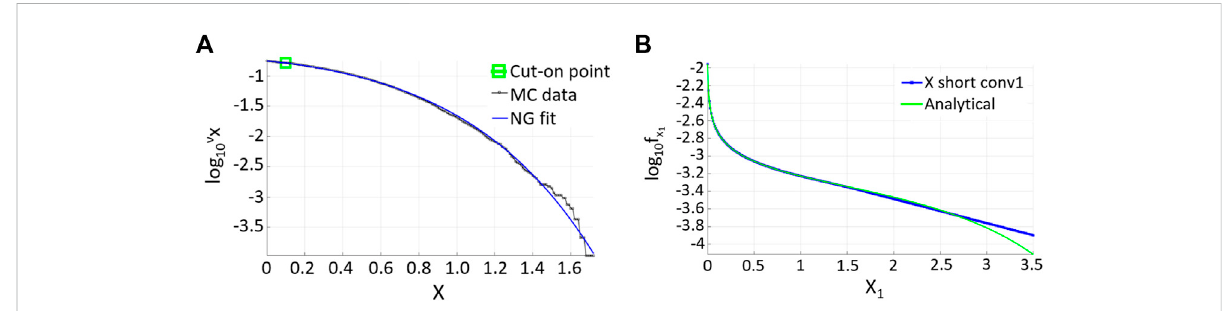
FIGURE 1 (A) NG fi toftheMC-simulatedDuf fi ngresponsefor f X . (B) Deconvoluteddistribution,linearlyextrapolated (blue) f X 1 versustheanalyticsolution